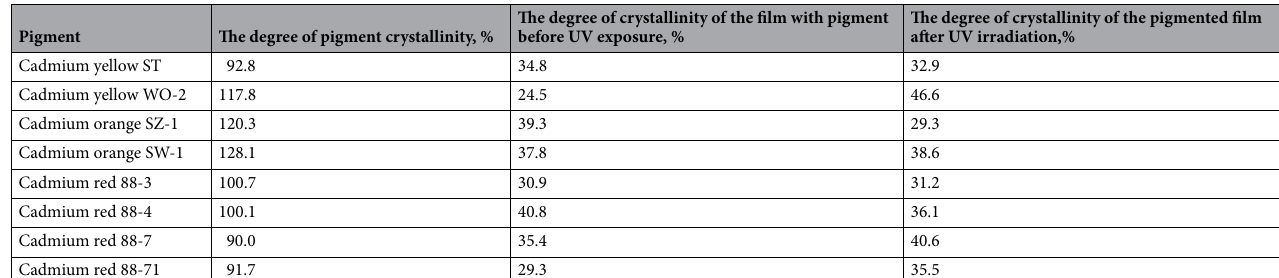
Table 6. Values of crystalinity degree of cadmium pigments and membranes with cadmium pigments before and after exposure to UV radiation.